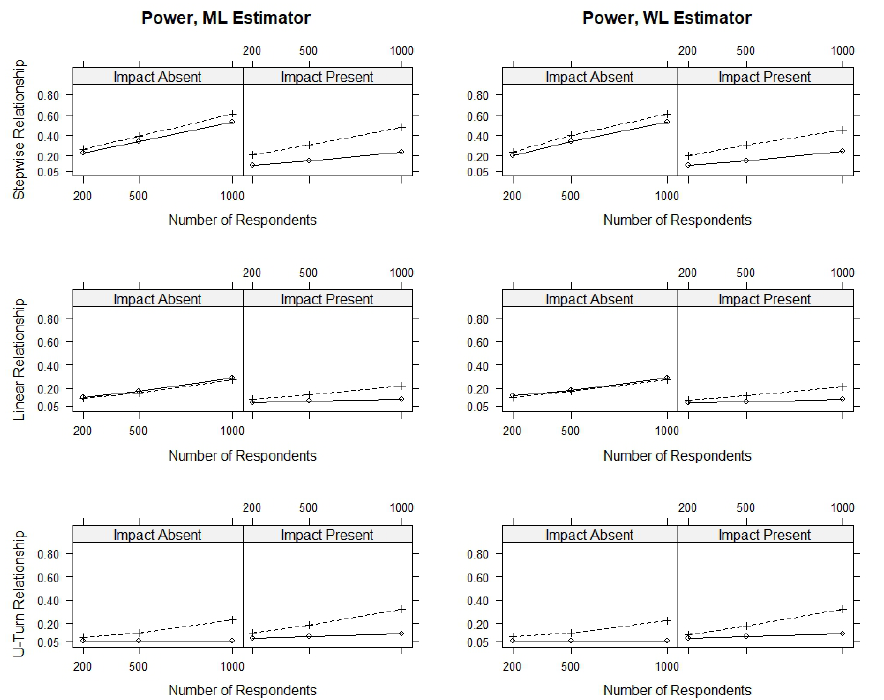
Figure A4. Power of two tests against unbalanced DIF in the β parameter for modules of 9 items. Only items suspected to be DIF-free are used for ability estimation. The unbroken line presents the results for the linear logistic regression test, the broken line presents the results for the score-based bootstrap